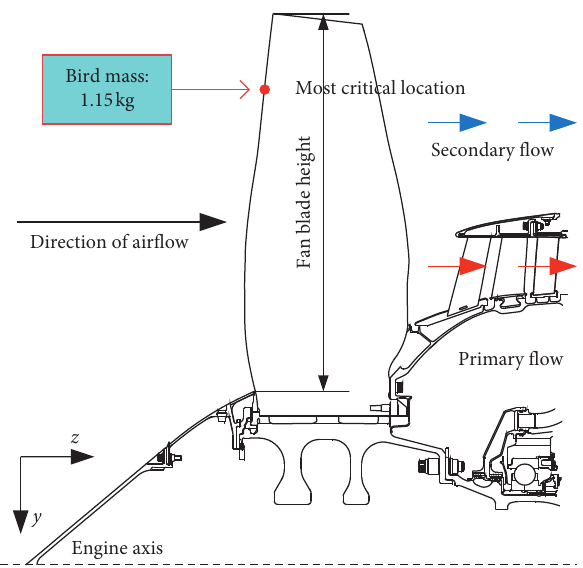
Figure 3: Location of target point on the leading edge of a fan